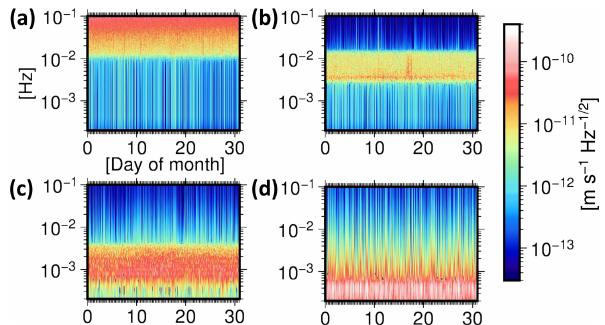
Figure 6. Time–frequency analysis of (a) short timescale, (b) medium timescale, (c) long timescale, and (d) approximation components of the residual signal. Spectrograms are computed with a window length of 5h for December 2008.